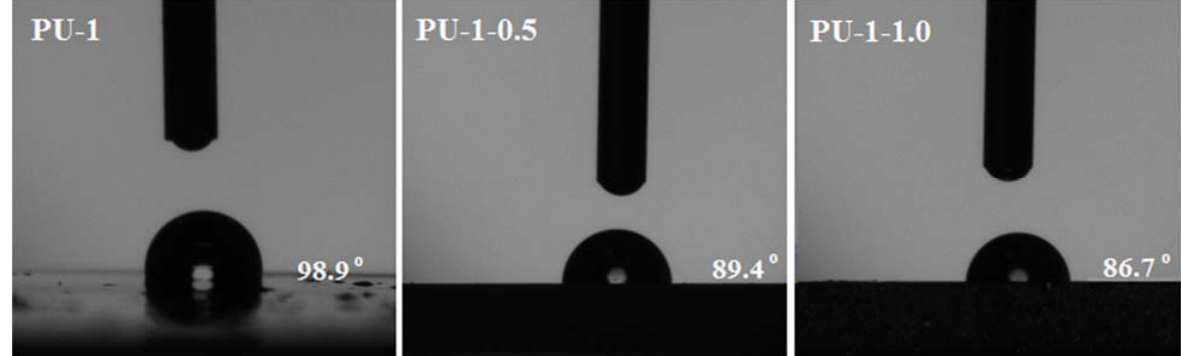
Figure 5. Static contact angle measurements for the neat PU-1 film surface and the corresponding composites (PU-1-0.5 and PU-1-1.0) at room temperature.